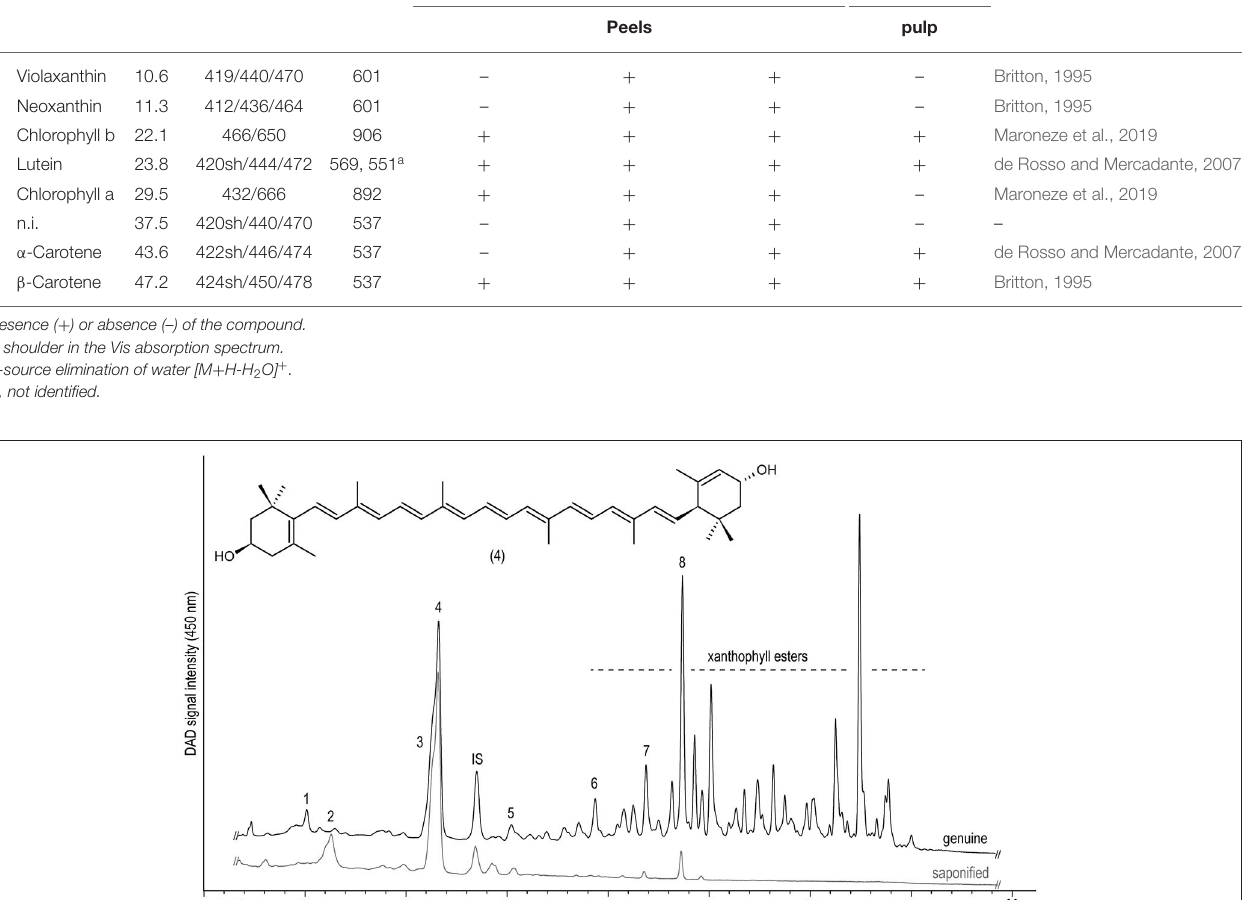
TABLE 5 | HPLC retention times ( t R ), Vis absorption maxima, APcI( in the pulp of cv. Caturra Amarillo. No. Proposed identity